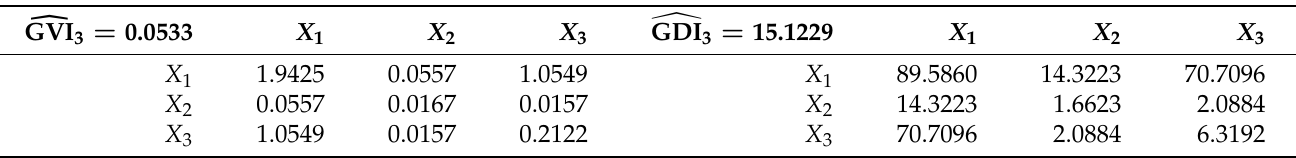
Table 3. Empirical univariate (in diagonal), bivariate (o ff diagonal) and trivariate (at the corner) variation (6) and dispersion (3) indexes.